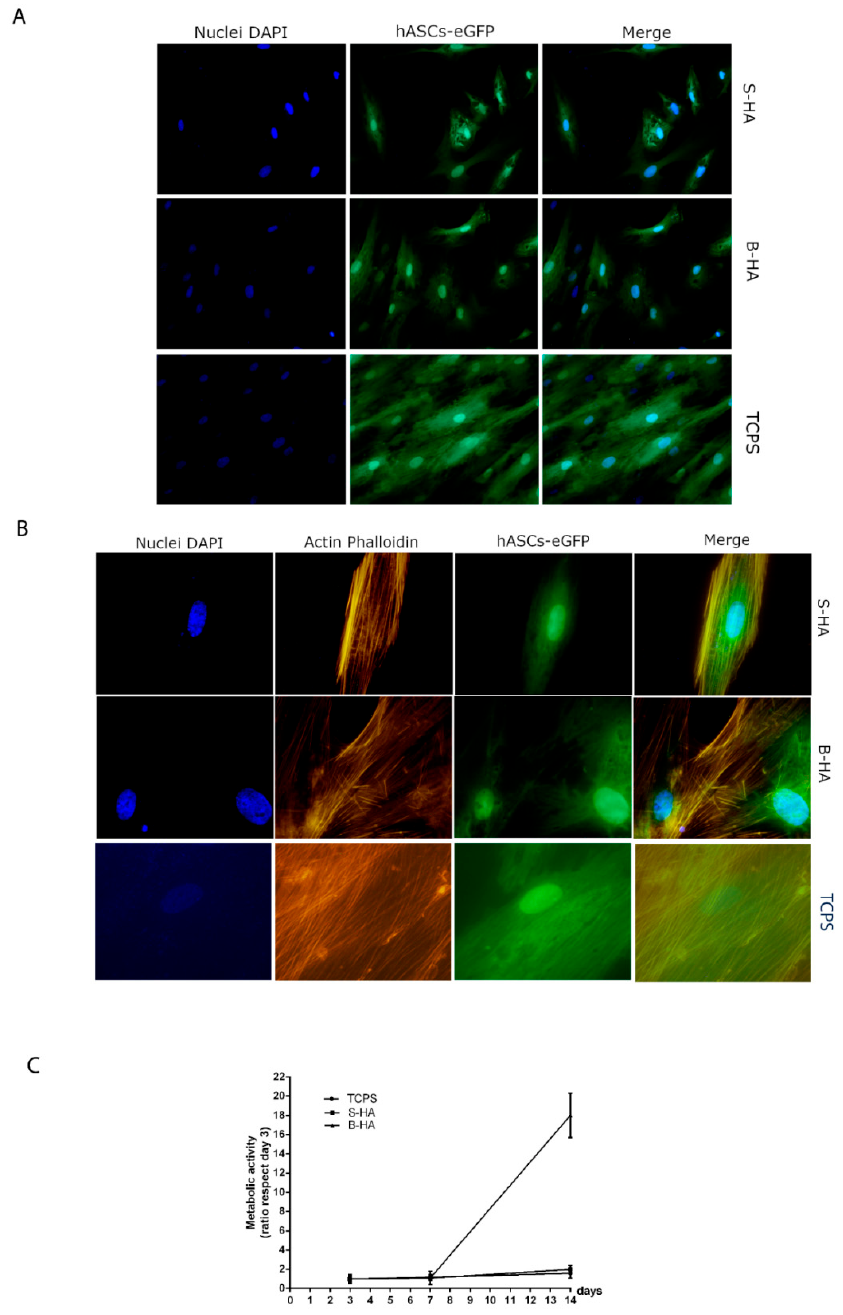
Figure 2. Stem cell viability and cytoskeleton architecture. ( A ) Recombinant genetically engineered human adipose stem cells (hASC-eGFP) grown on biomorphic HA (B-HA), sintered HA (S-HA) and tissue culture polystyrene (TCPS) at day 14 are shown at magnification 20 × . Cell nuclei were stained with 0.5 mg/mL DAPI. ( B ) Cytoskeleton analysis by Phalloidin TRITC staining was carried out in hASCs-eGFP grown on biomaterials B-HA and S-HA and TCPS (magnification 40 × ). Actin filaments show no structural alteration, confirming the compatibility of the assayed biomaterials, at day 14. Cell nuclei were stained with 0.5 mg/mL DAPI. ( C ) human adipose stem cells (hASCs) metabolic activity was evaluated by colorimetric intensity at day 3, 7 and 14 of co-culture on B-HA, S-HA and TCPS. 3D-Biomorphic biomaterials showed the highest value in cell viability between day 7 and day 14 ( p < 0.05). Statistically differences are significant for B-HA, S-HA and TCPS at day 7 and day 14 ( p <